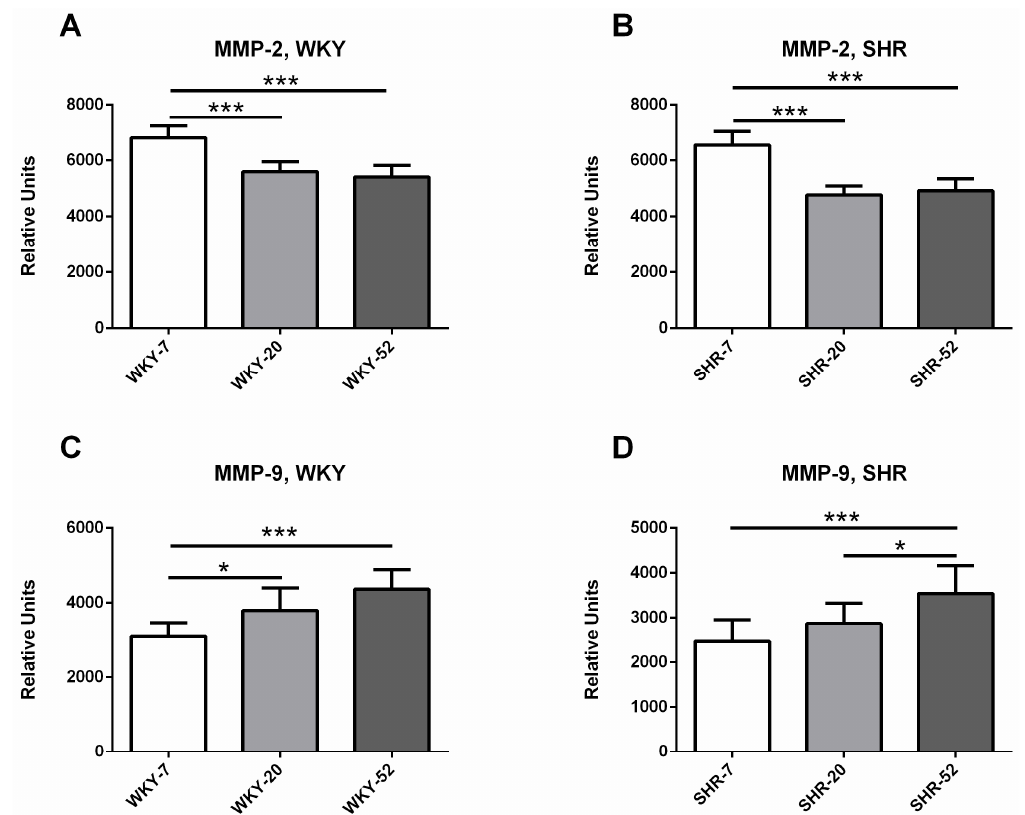
Figure 5. Age differences in the activity of MMP-2 in WKY ( A ) and SHR ( B ) and age differences in the activity of MMP-9 in WKY ( C ) and SHR ( D ). The data are presented as means ± SD. Statistical significance: * represents p < 0.05; *** represents p < 0.001. MMP—matrix metalloproteinase, WKY— Wistar-Kyoto rats, SHR—spontaneously hypertensive rats.